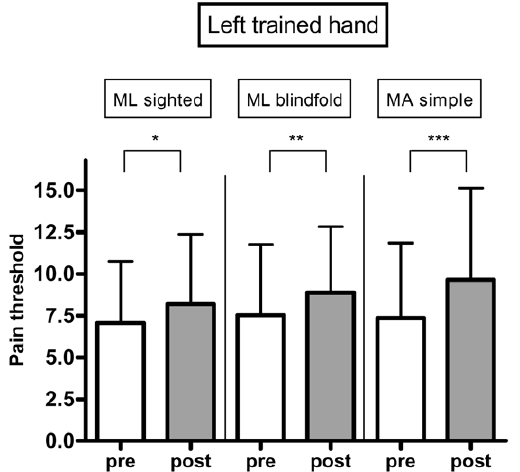
Figure 4. Results of pain thresholds: right hand. Pressure pain threshold levels before and after the tasks for the right untrained control hand. Ns=not significant.